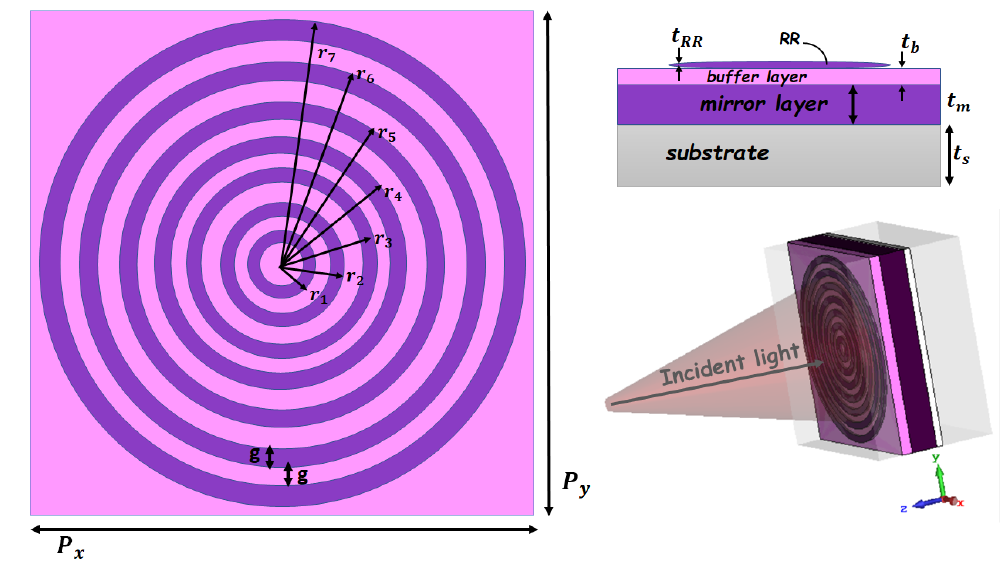
Figure 1. The 2D and 3D views of the proposed design ( unit cell G ). Table 1. The geometrical parameters of the designed unit